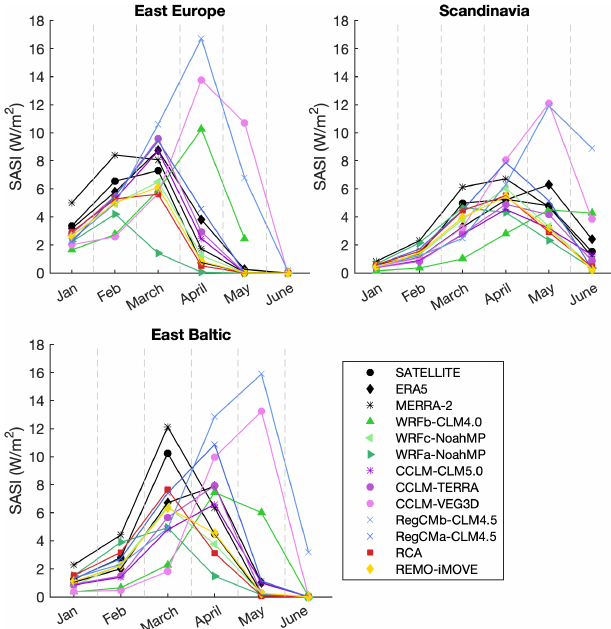
Figure 4. Time series of the spatial average of SASI for the satellite observations, the reanalysis ERA5-Land and the 10 RCMs from the EVAL experiment of LUCAS in Scandinavia, East Europe and East Baltic (see Fig. 1 for their spatial extent). Data are averaged over the time period